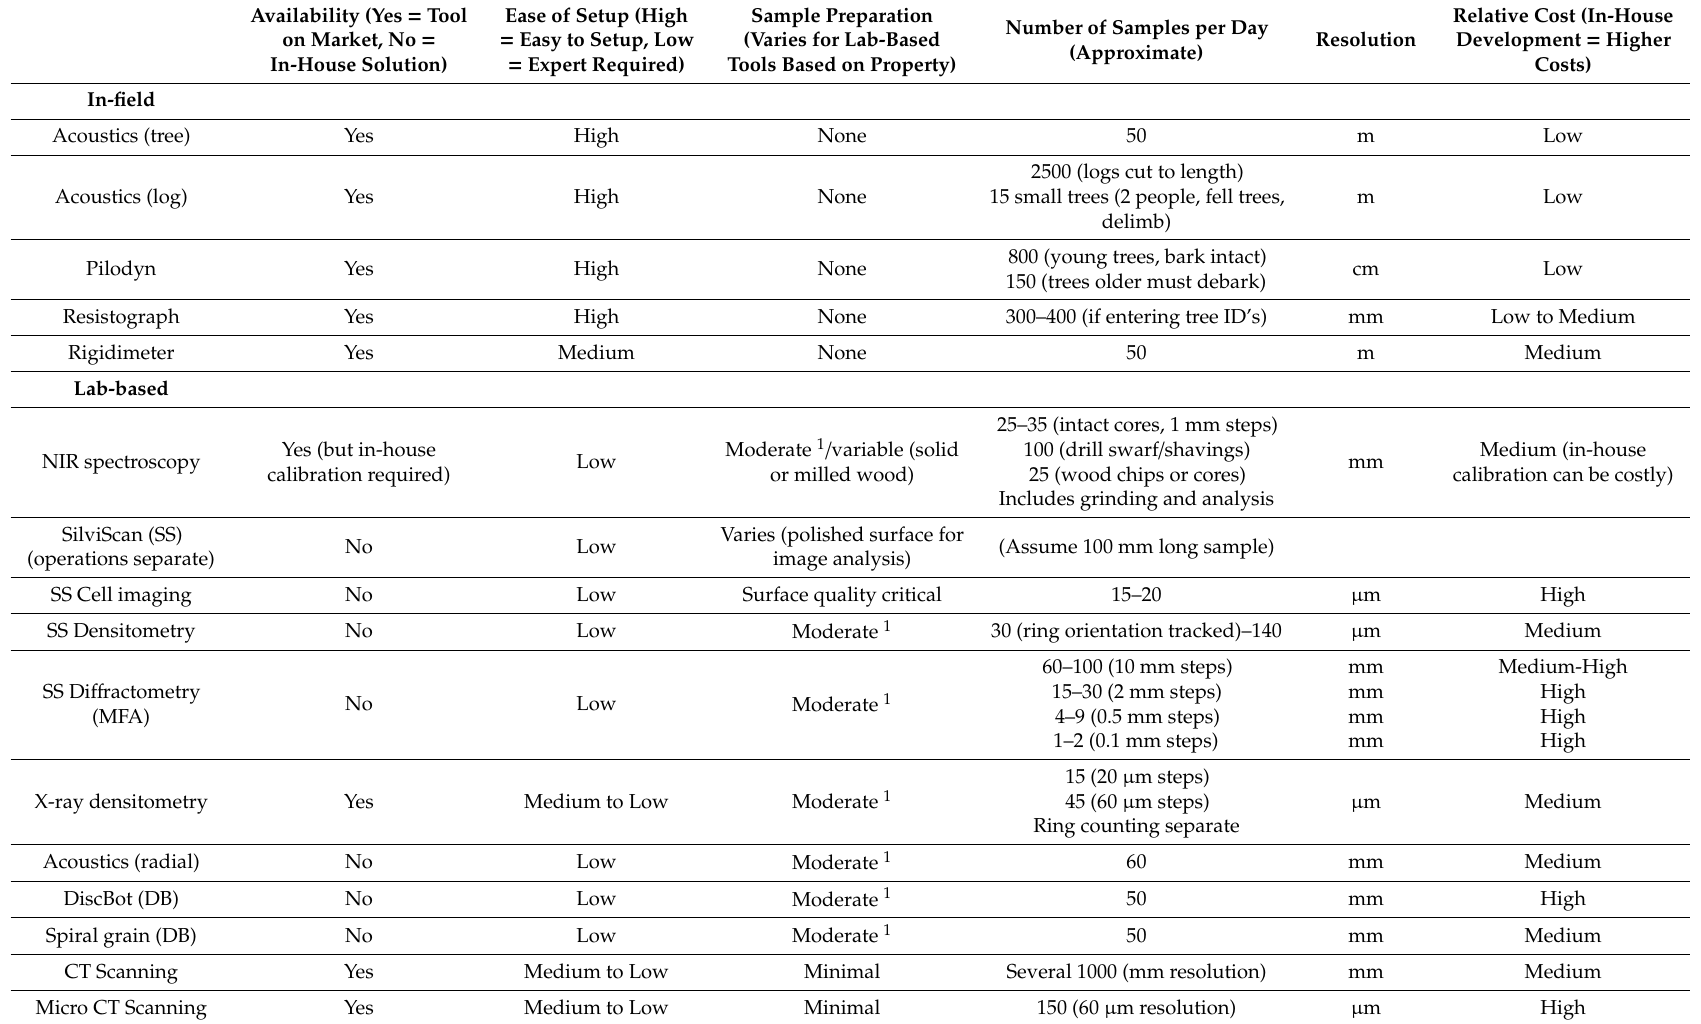
Table 4. Summary of key features of each NDE